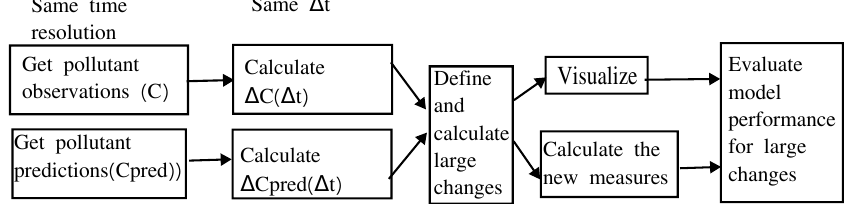
Figure 1. The flow of the proposed methods for air pollutant model predictions visualization and